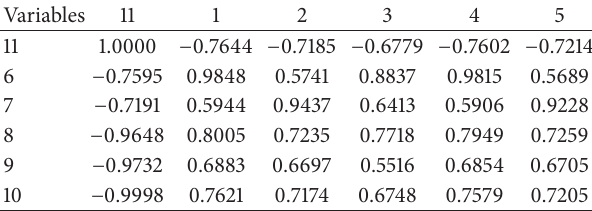
Table 1: PLS coefficients refer to eleven variables.